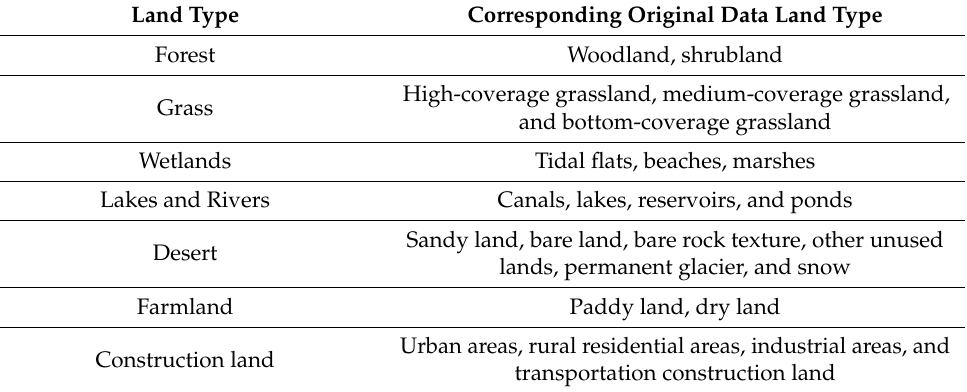
Table 1. Equivalent land use categories between the raw data. Land Type Corresponding Original Data Land Type Forest Woodland, shrubland High-coverage grassland, medium-coverage grassland, Grass and bottom-coverage grassland Wetlands Tidal flats, beaches, marshes Lakes and Rivers Canals, lakes, reservoirs, and ponds Sandy land, bare land, bare rock texture, other unused Desert lands, permanent glacier, and snow Farmland Paddy land, dry land Urban areas, rural residential areas, industrial areas, Construction land